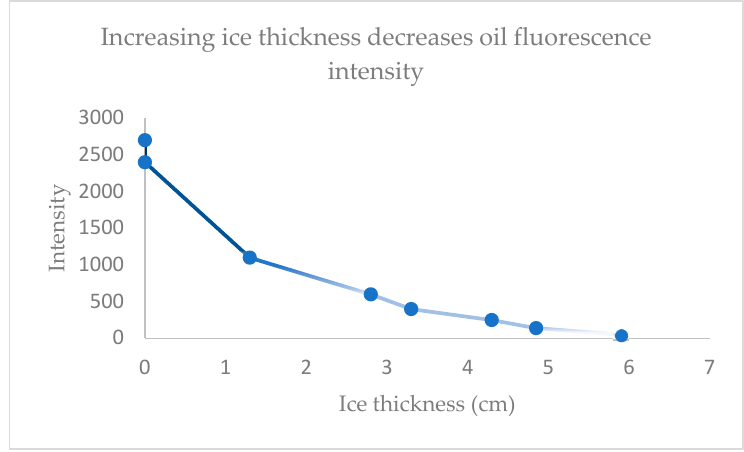
Figure 10. Graph of the effect of ice thickness on the intensity of oil fluorescence [66].